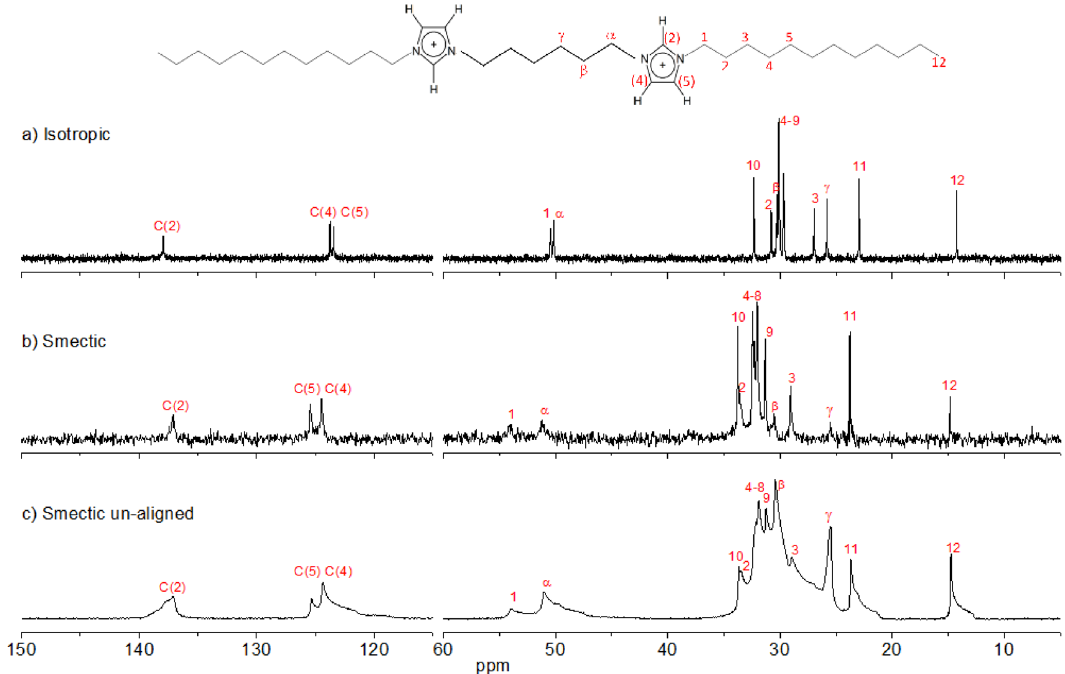
Figure 1. 13 C NMR spectra of C 6 (C 12 im) 2 Br 2 in the isotropic phase at 140 °C ( a ) and smectic phase ( b , c ) at 111 °C. The spectrum ( b ) was recorded in the aligned mesophase using a single scan with cross-polarization (CP) enhancement. The spectrum ( c ) was recorded in the un-aligned mesophase with the number of scans 1024 and using nuclear Overhauser effect (NOE) enhancement. The cation structure with atom labeling is shown on the